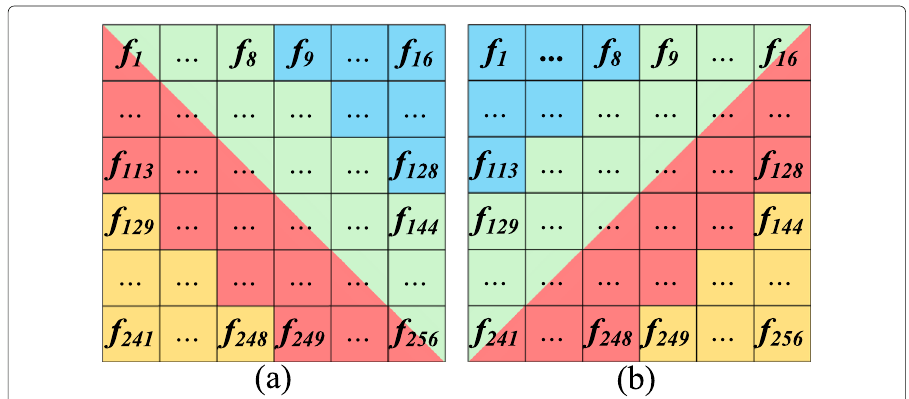
Fig. 3 The diagrams of diagonal ( a ), and anti-diagonal ( b ) average poolings. Elements marked by the same color are